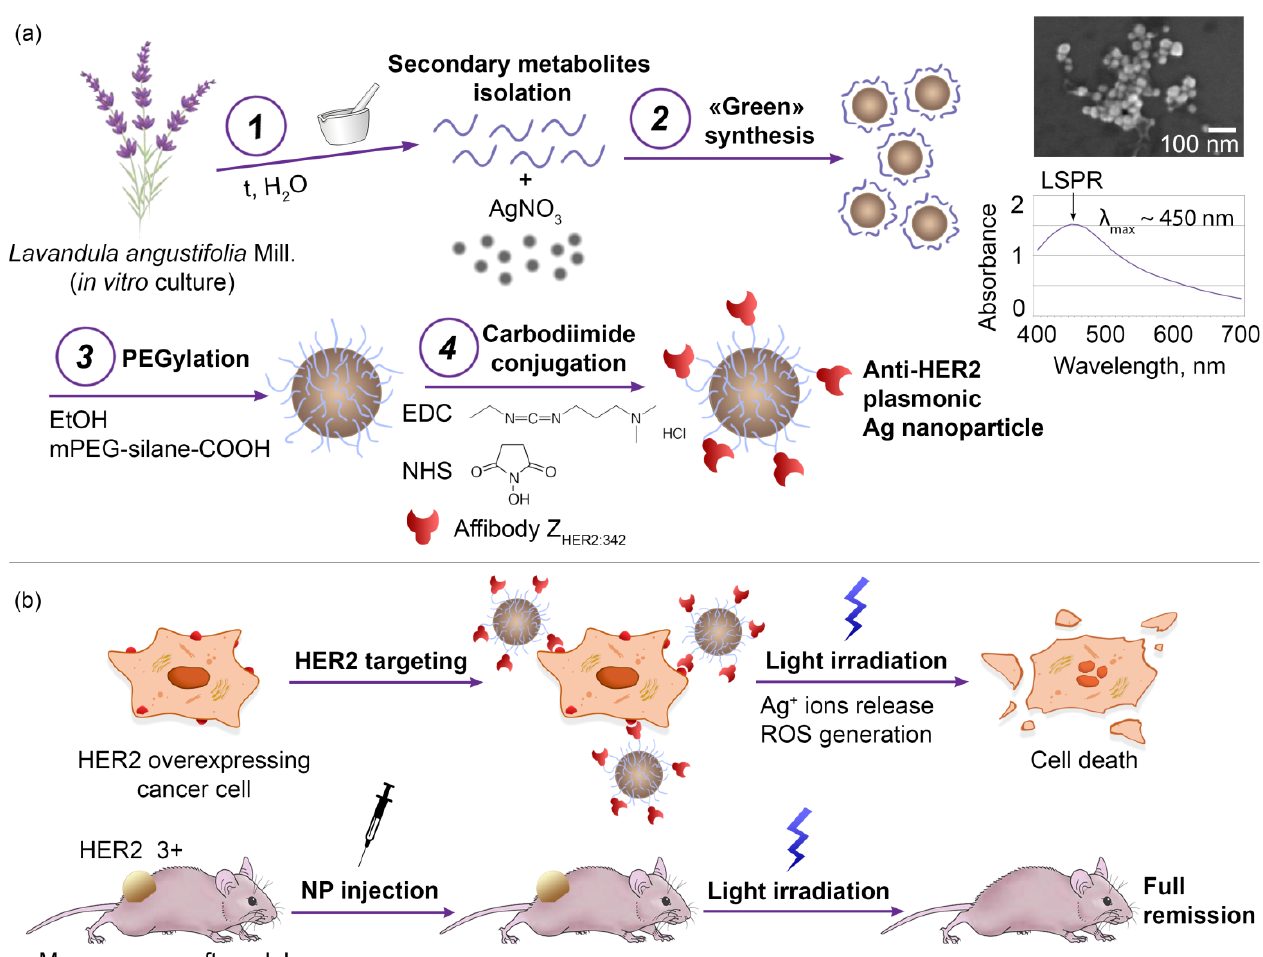
Figure 1. Experimental design of Ag NP synthesis and modification for the HER2-targeted photo- thermal therapy in vitro and in vivo. ( a ): “Green” nanoparticle synthesis via the reduction of silver nitrate with Lavandula angustifoli a Mill. secondary metabolites (1–2), modification of NP surface with scaffold polypeptide—affibody Z HER2:342 through the intermediate PEGylation (3), and carbodiimide